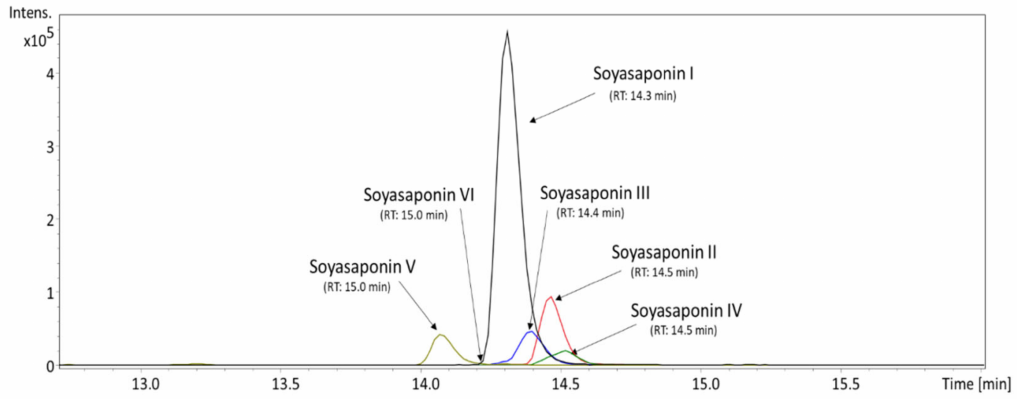
Figure 2. Extracted ion chromatogram of soyasaponins from the methanol extract of doenjang, represented as m / z of [M + H] +